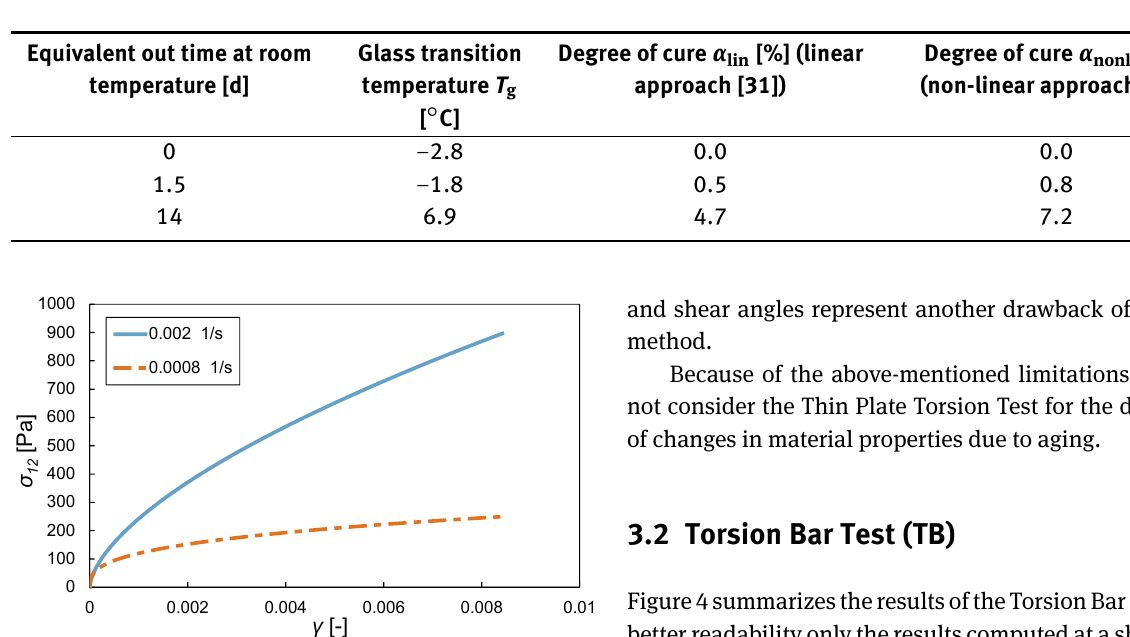
Table 3: Tested material conditions